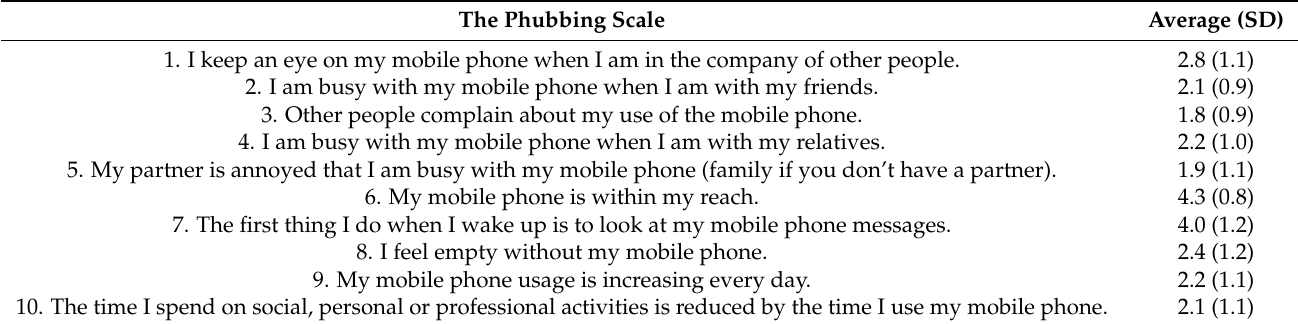
Table 5. Average values obtained in the items of The Phubbing Scale (n = 192).